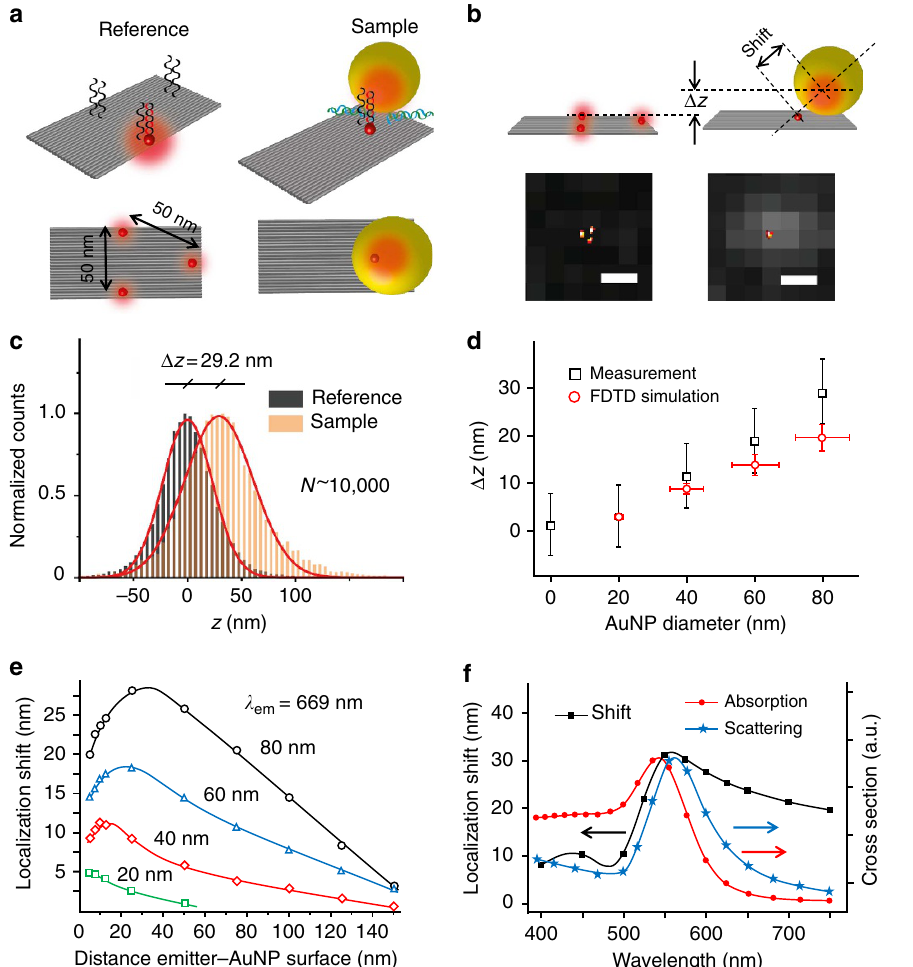
Figure 3 | Quantification of the localization shift induced by gold nanoparticles (AuNPs). ( a ) Schematic representation of the DNA origami structures used in the assay (perspective and top views). ( b ) Scheme showing the total shift in the position of the emission centre and the shift in axial position ( D z ) induced by the AuNP, together with representative 2D DNA-PAINTsuper-resolution images of the reference and sample structures (scale bars, 200nm). ( c ) Distributions of axial localizations obtained in the reference and the sample with 80nm AuNPs. ( d ) Average shift produced by the AuNPs as a function of the AuNP diameter, together with the predicted shift obtained from full-field 3D simulations. Experimental error bars indicate 3 s in the average D z (details in Supplementary Note 1). The error bars in the simulations correspond to allowed dimensional ranges in the DNA origami structures (see Supplementary Table 1) and the size distributions of the AuNPs. ( e ) Simulated localization shift produced by AuNPs of different diameters, as a function of the separation distance between the emitter and the AuNP surface. ( f ) Simulated localization shift as a function of the emission wavelength for an emitter placed at 10nm from an 80nm AuNP, together with the scattering and the absorption spectra of the